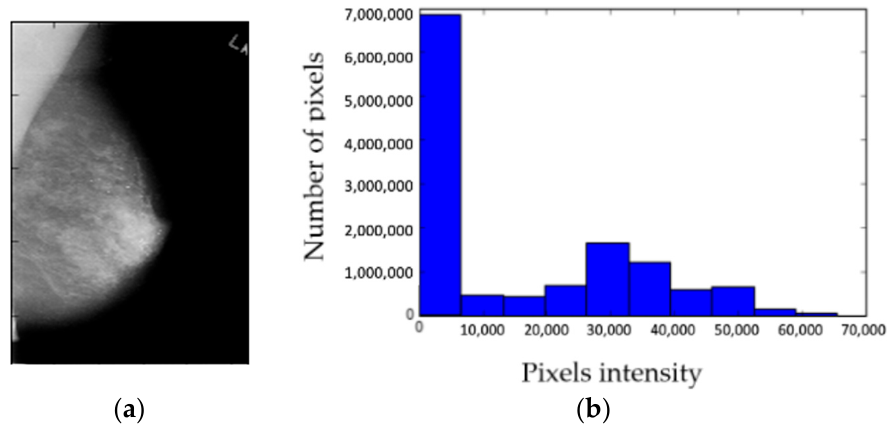
Figure 6. Mammography DICOM image ( a ) and its corresponding histogram ( b ).